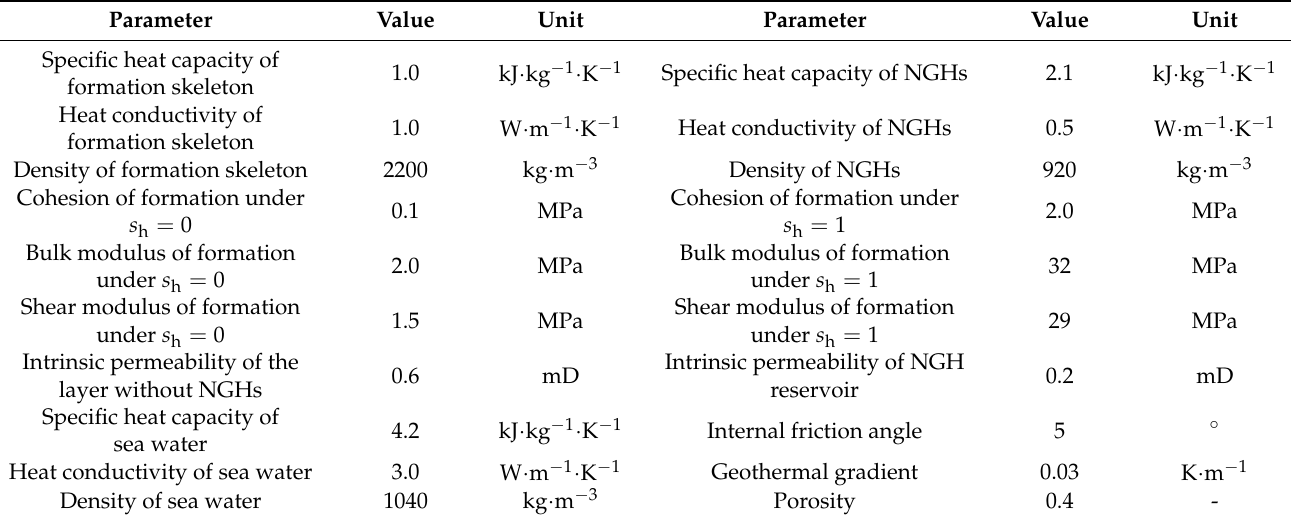
Table 2. Basic parameters of the formation [32].